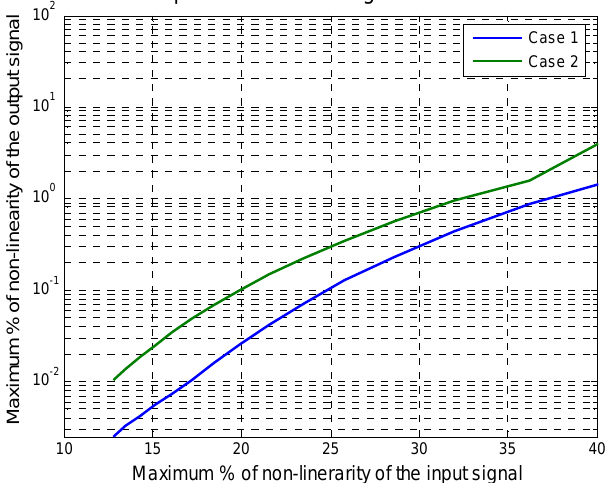
Figure 4. Algorithm response with seven points of